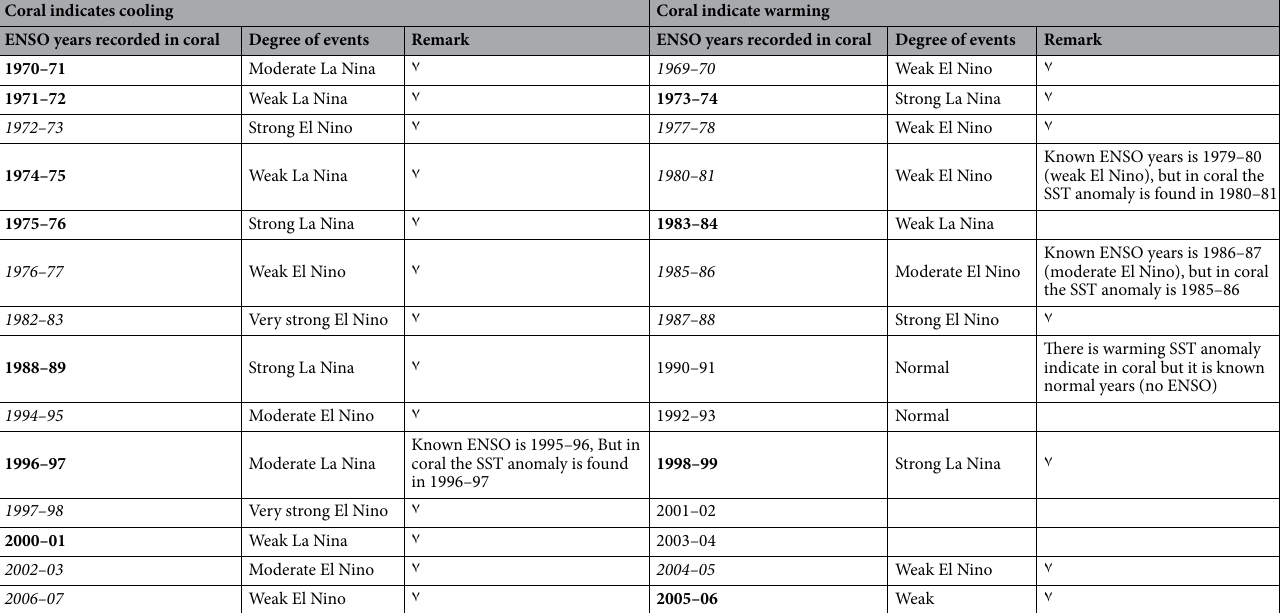
Table 2. ENSO years and their SST signature in the Enggano Sr/Ca record. 1991–92 : Strong El Nino. 1984–85 : Weak La Nina. 1999–00 : Strong La Nina.